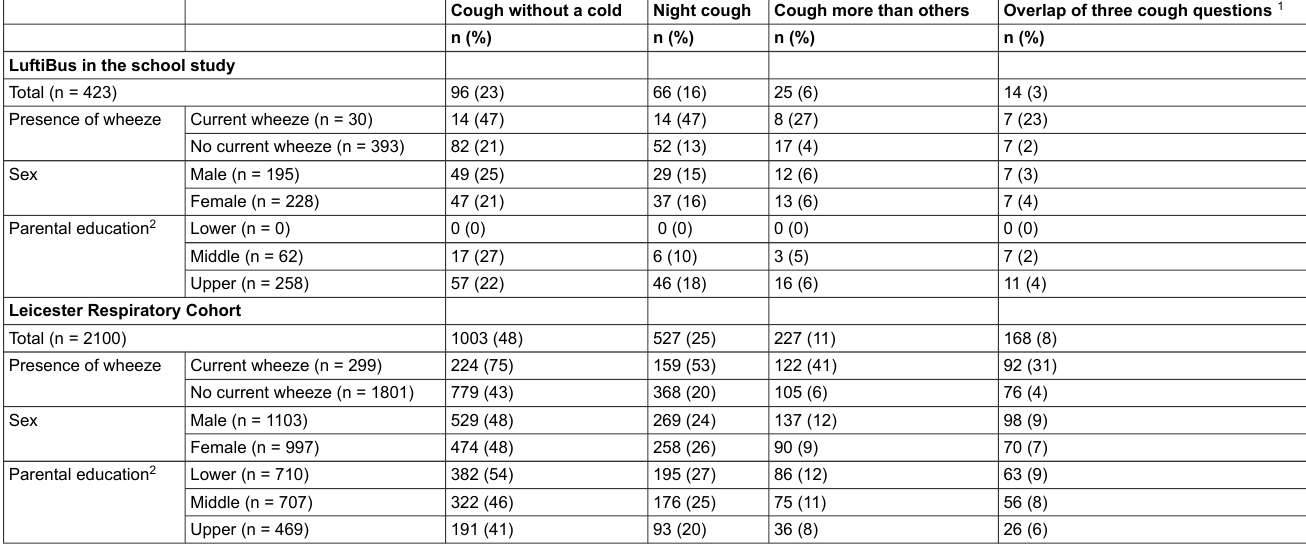
Table S3: Prevalence of cough based on parents’ answers to differently worded questions and stratified by presence of wheeze, sex, and parental education in a subgroup of school chil- dren aged 6–8 years (n = 423) from the LuftiBus in the school (LUIS) study compared to school children aged 6–8 years from the Leicester Respiratory Cohort (LRC) (n = 2100) (row percentage).